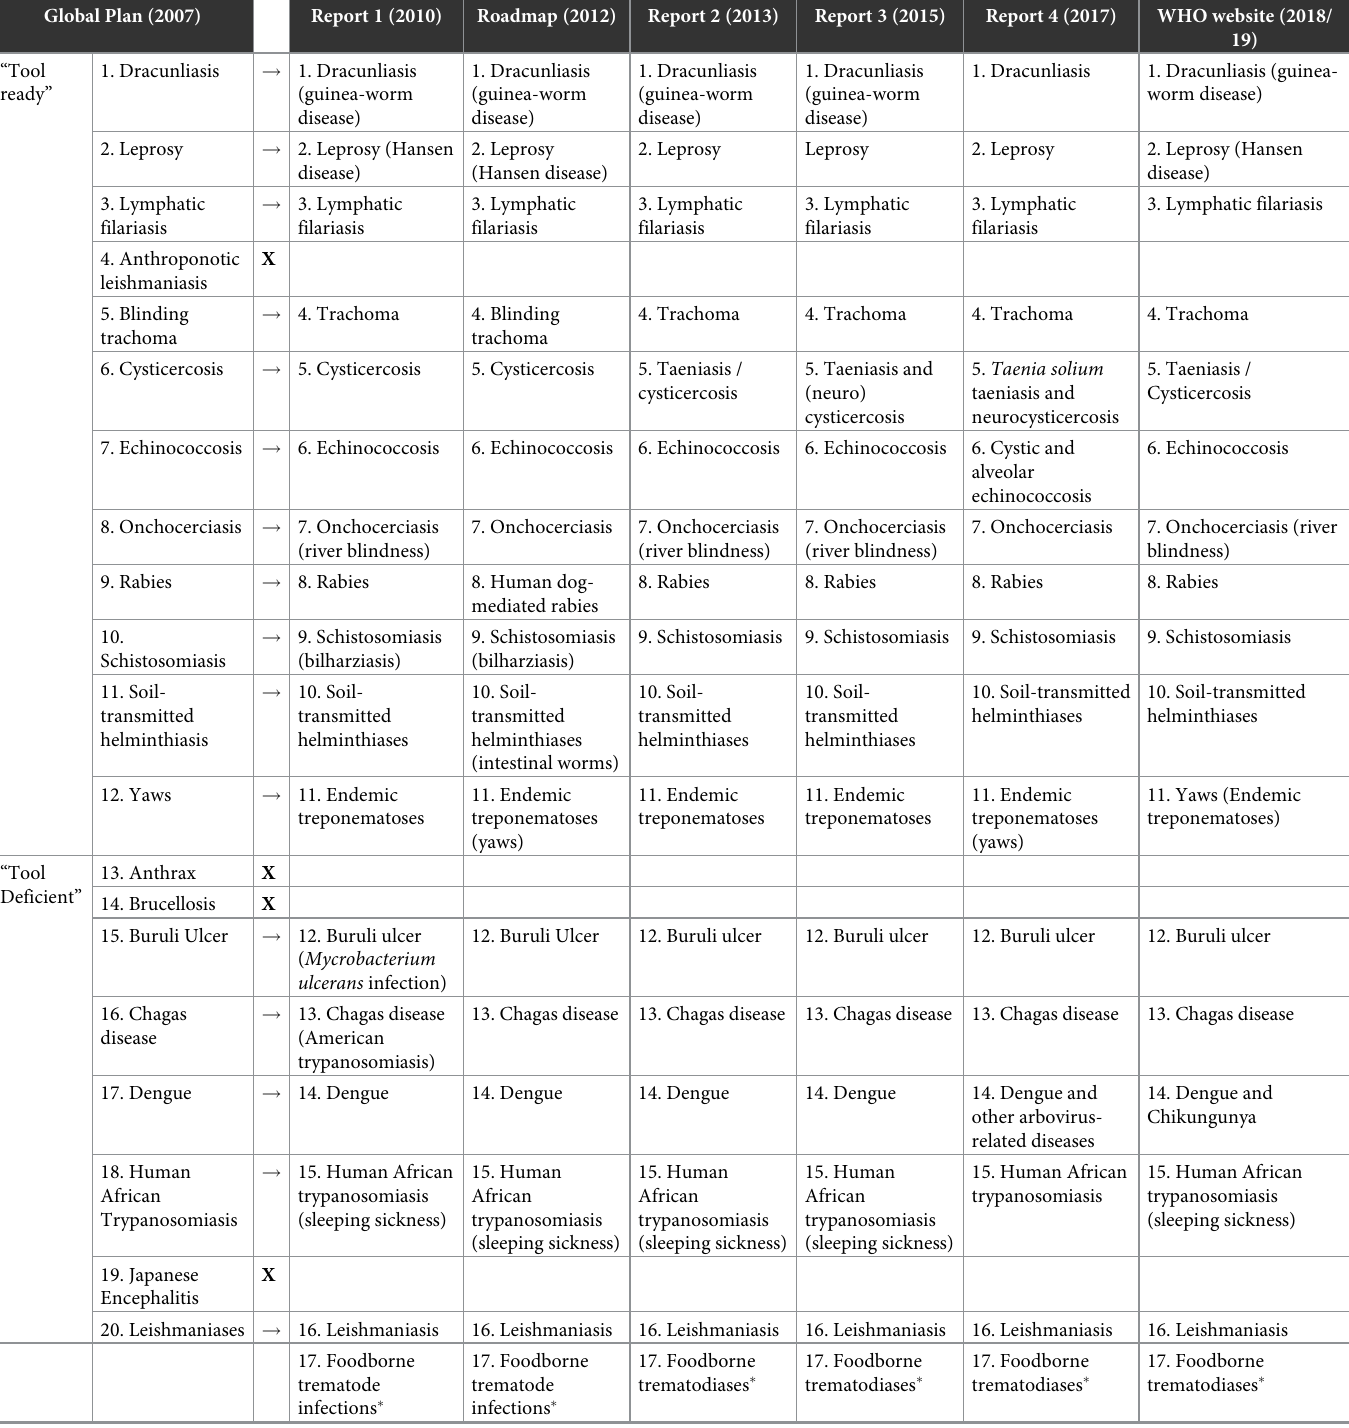
Table 1. NTDs prioritized by WHO as reported in global documents and website. Global Plan